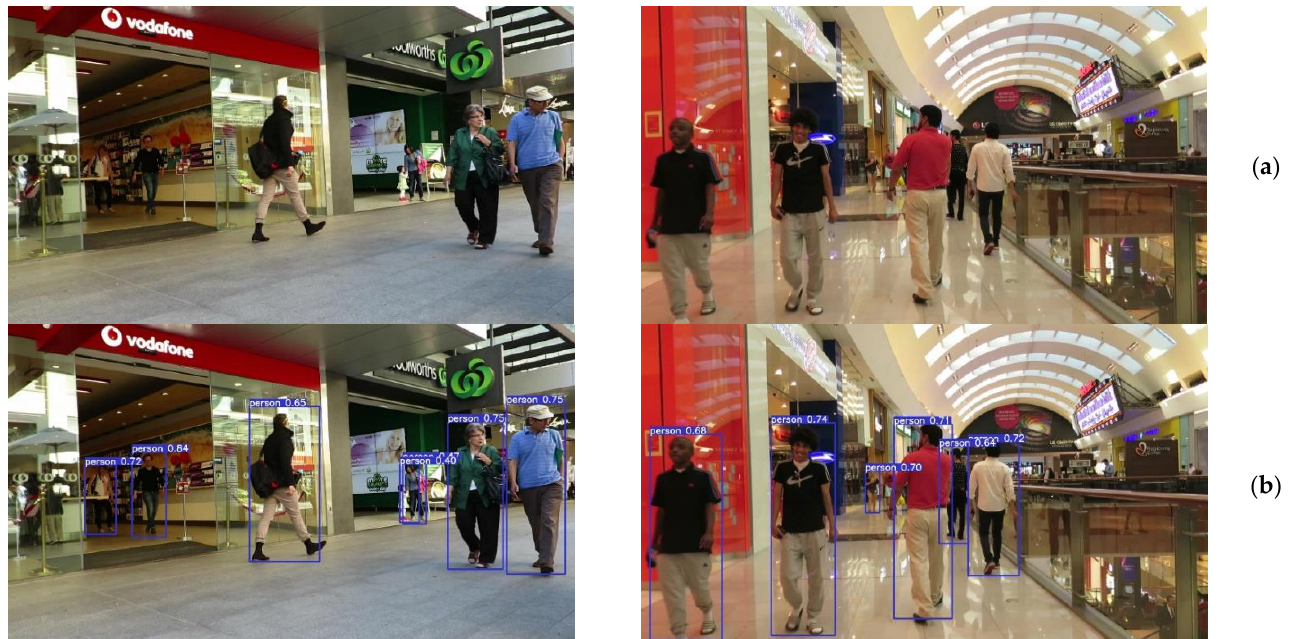
Figure A4. Detection results on 2 images from the MOT17Det dataset. ( a ) Original image samples. ( b ) Output samples.